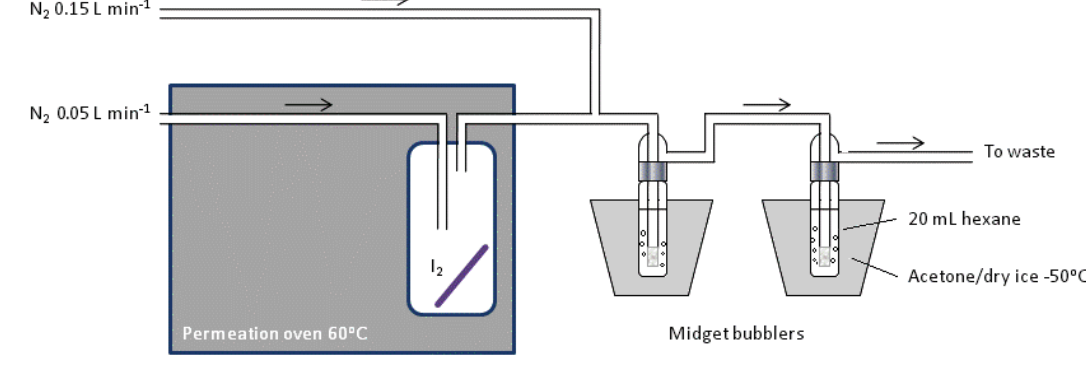
Fig. 2. Optimised solvent trap experimental set up.